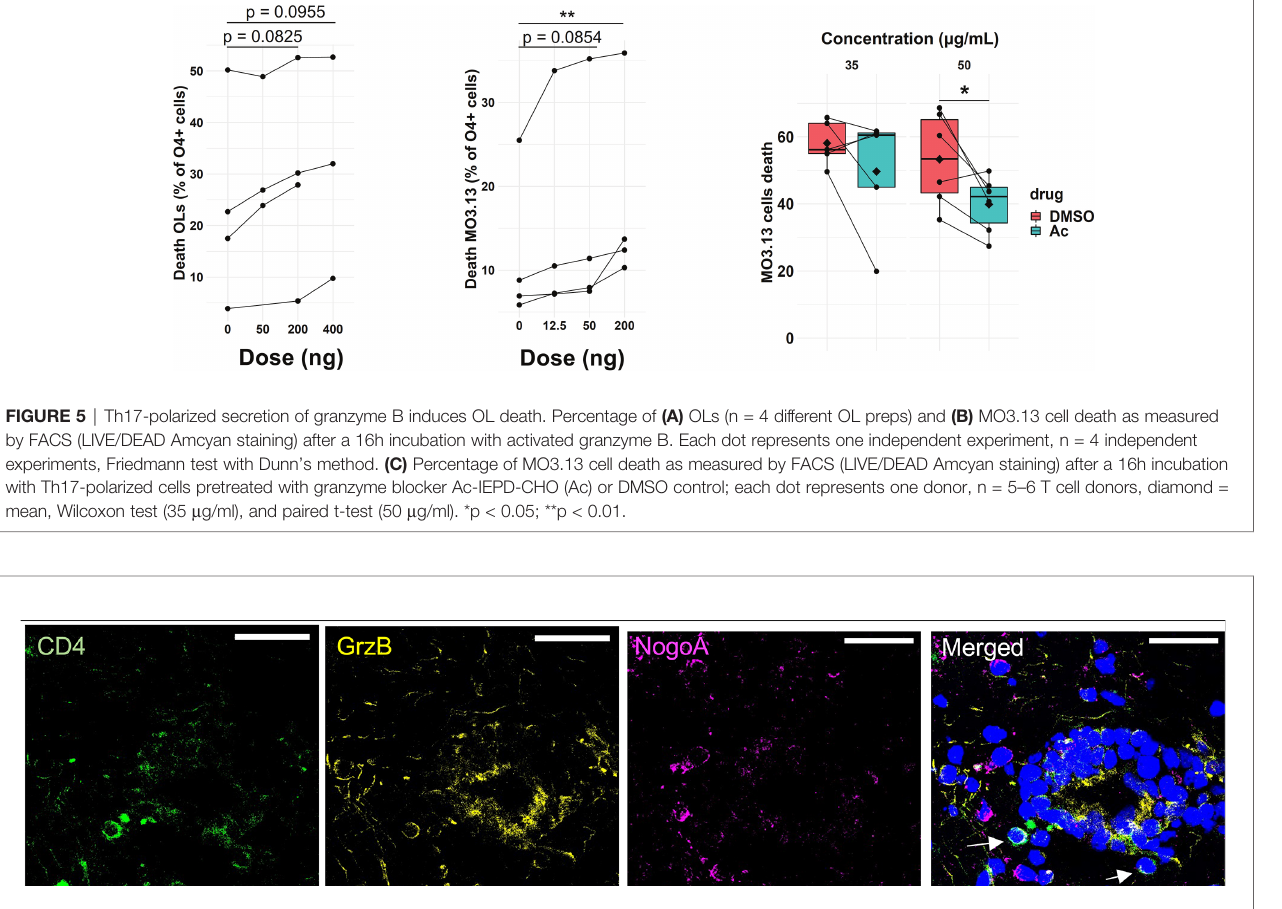
FIGURE 6 | CD4 T cells express granzyme B in proximity to OLs in MS tissue. Representative confocal images of CD4 + cells (green) positive for granzyme B (yellow, upper panel) shown by arrows in proximity to mature OLs (NogoA, magenta) in MS tissue. Representative of two donors, scale bar = 30 m